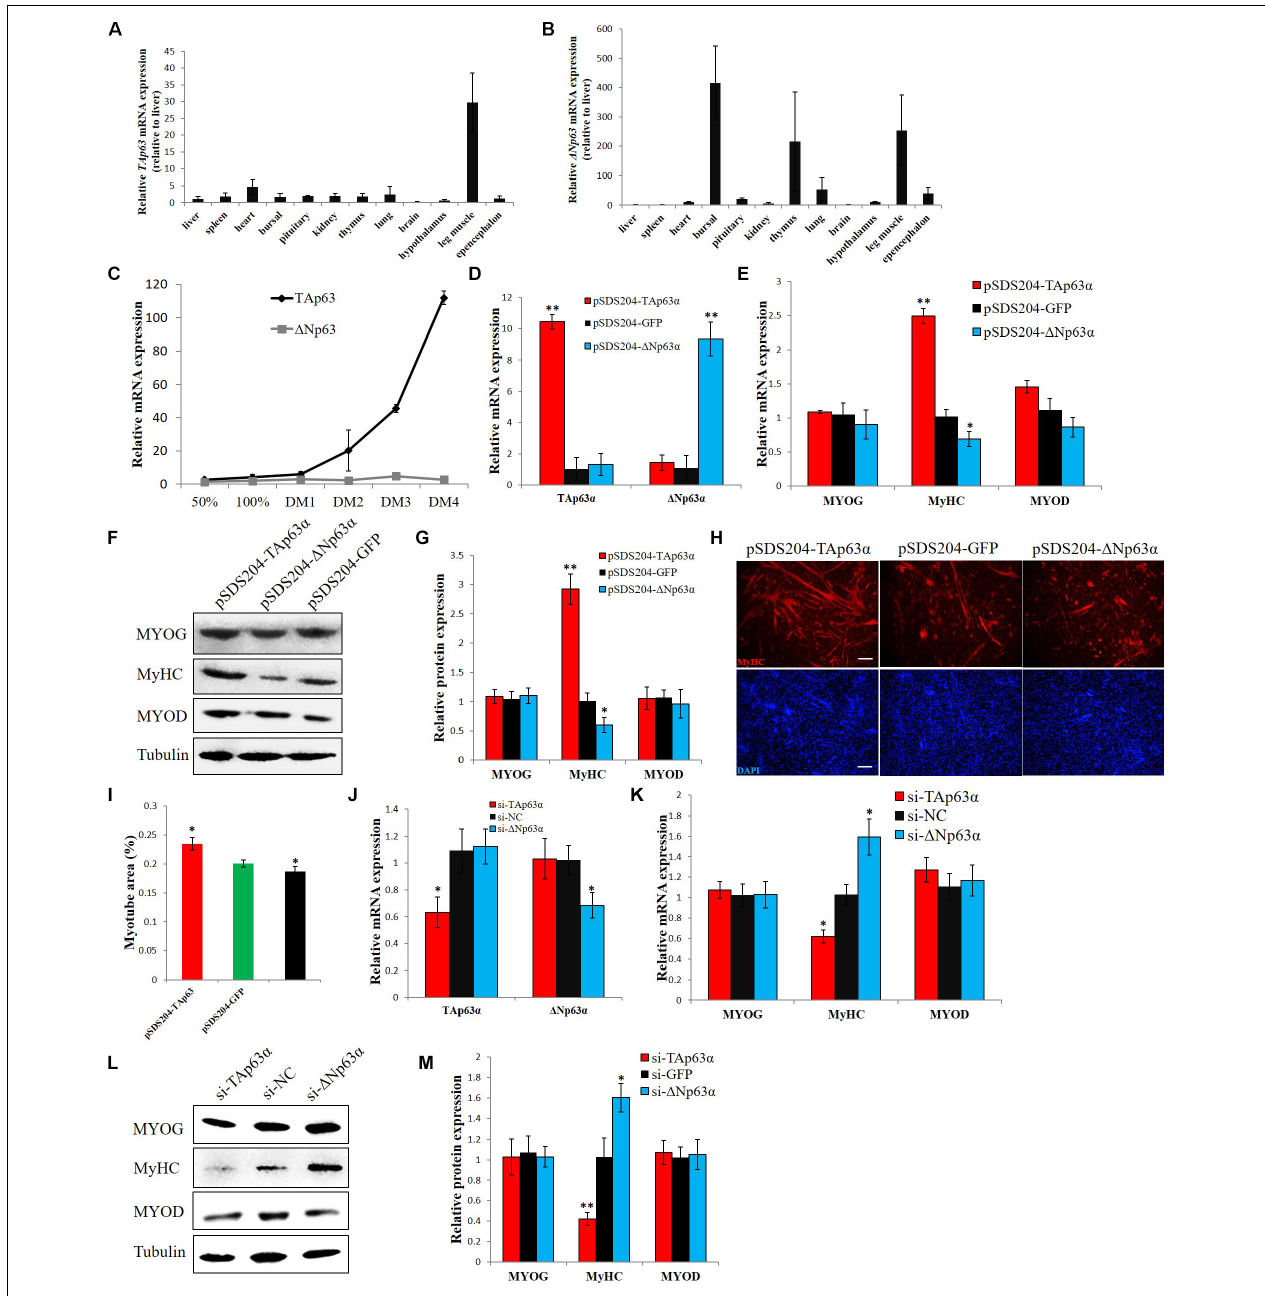
FIGURE 3 | TAp63 α and (cid:49) Np63 α play opposite roles in chicken myogenic differentiation. (A) qPCR for detecting the relative mRNA expression of TAp63 in 12 tissues from 7-week-old chickens. (B) qPCR for detecting the relative mRNA expression of (cid:49) Np63 in 12 tissues from 7-week-old chickens. (C) Relative mRNA expression of TAp63 and (cid:49) Np63 during chicken primary myoblast differentiation. (D) Relative mRNA expression of TAp63 and (cid:49) Np63 after the transfection of pSDS204-TAp63 α , pSDS204- (cid:49) Np63 α , or pSDS204-GFP. (E) Relative mRNA expression of muscle differentiation marker genes after the transfection of pSDS204-TAp63 α , pSDS204- (cid:49) Np63 α , or pSDS204-GFP. (F) Protein expression of muscle differentiation marker genes after the transfection of pSDS204- TAp63 α , pSDS204- (cid:49) Np63 α , or pSDS204-GFP. (G) Relative protein expression after transfection of pSDS204-TAp63 α , pSDS204- (cid:49) Np63 α , or pSDS204-GFP. (H) MyHC immunostaining in primary myoblasts transfected with pSDS204-TAp63 α , pSDS204- (cid:49) Np63 α , or pSDS204-GFP and differentiated for 48 h. The nuclei were visualized with DAPI. Bar, 100 µ m. (I) Myotube area (%) at 48 h after the transfection of pSDS204-TAp63 α , pSDS204- (cid:49) Np63 α , or pSDS204-GFP. (J) Relative mRNA expression of TAp63 and (cid:49) Np63 after transfection of si-TAp63 α , si- (cid:49) Np63 α , or si-NC. (K) Relative mRNA expression of muscle differentiation marker genes after transfection of si-TAp63 α , si- (cid:49) Np63 α , or si-NC. (L) Western blotting results for muscle differentiation marker genes after the transfection of si-TAp63 α , si- (cid:49) Np63 α , or si-NC. (M) Relative protein expression after the transfection of si-TAp63 α , si- (cid:49) Np63 α , or si-NC. The data are the mean ± SEM of three cultures per group, and three wells per culture were assayed ( n = 9/treatment group). An independent samples t -test was used to analyze the statistical differences between groups. ∗ p < 0.05; ∗∗ p <